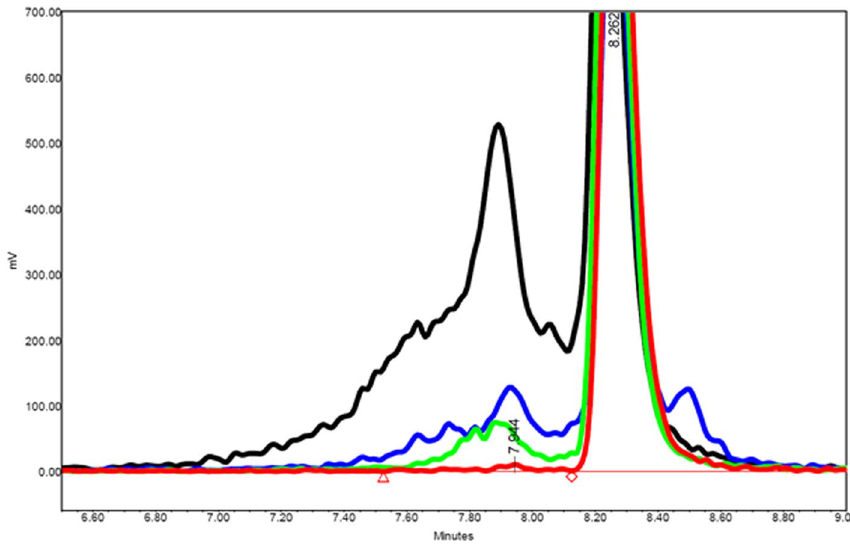
Fig. 3 Radiolysed [ 177 Lu]Lu-PSMA-I&T with a RCP varying from clinical labeling [97% (red)] and degraded radiopharmaceutical [90% (green), 70% (blue) and 50% (black)] for the cell-uptake